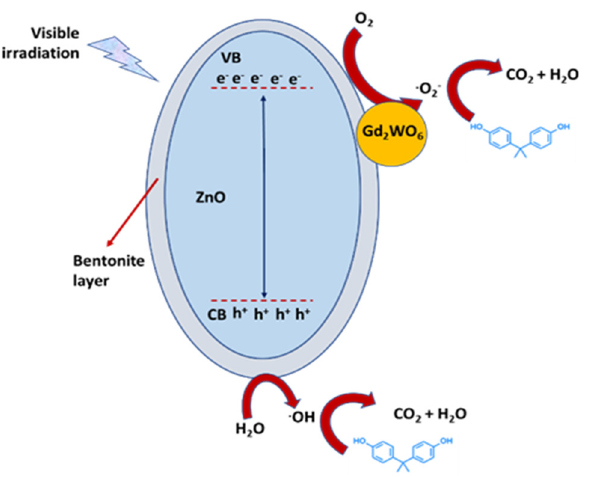
Figure 7. Proposed mechanism for the photodegradation of organic pollutants on a Gd 2 WO 6 /ZnO/ bentonite ternary composite, as described into